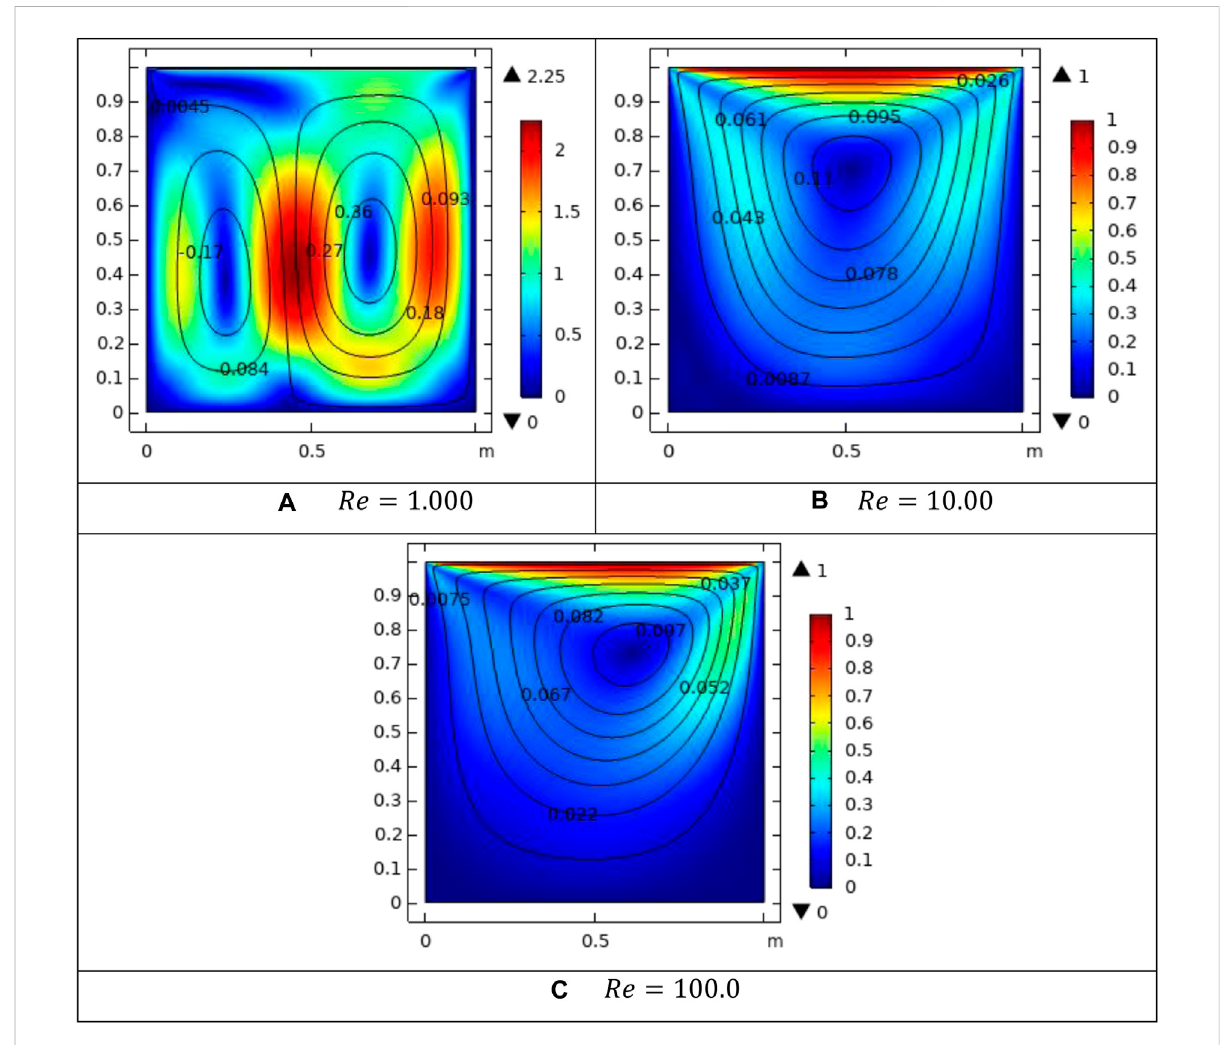
FIGURE 7 In fl uence of Re on streamlines for the uniform heating case: (A) Re (cid:1) 1 . 000, (B) Re (cid:1) 10 . 00, and (C) Re (cid:1) 100 . 0.